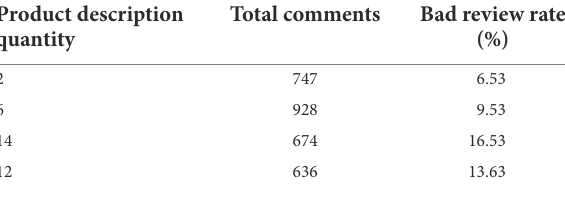
TABLE 3 Correlation analysis data